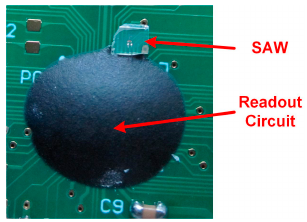
Figure 17. Chip-on-board (CoB) package of the readout chip and SAW device.